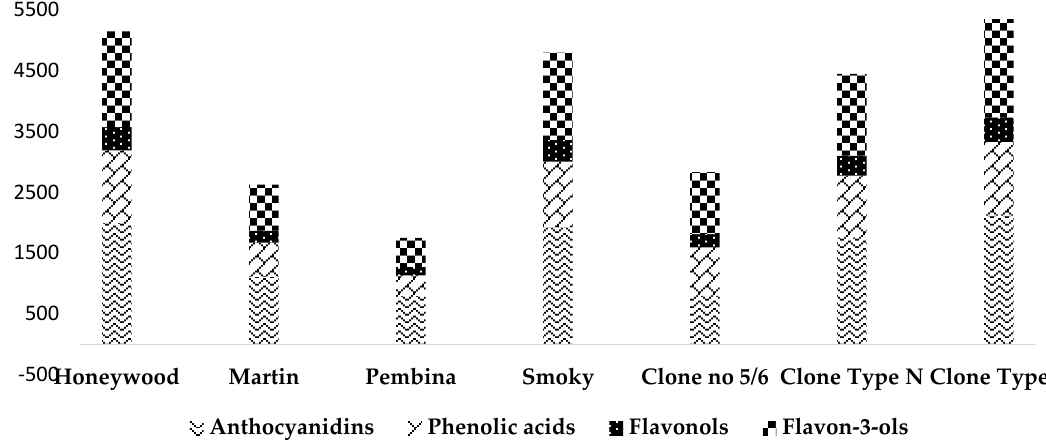
Figure 1. The content of polyphenolic compounds (mg/100 g · dm) of fruits in seven Saskatoon berry genotypes analyzed in 2016.